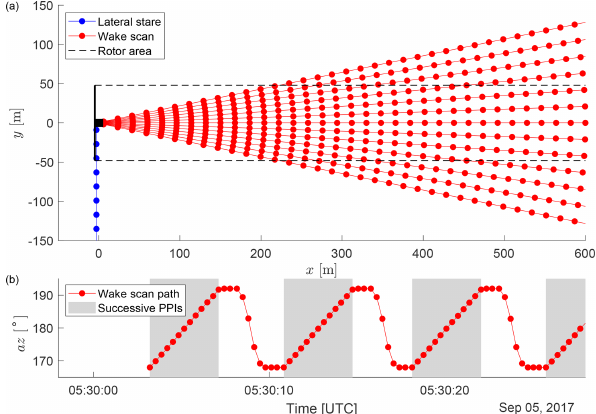
Figure 2. Scan patterns of the nacelle-mounted Doppler lidars viewed from the top (a) . Wake scans of the backward-facing Doppler lidar (red) were accompanied by measurements in a later- ally staring mode of the forward-facing Doppler lidar (blue). Lidar beams are shown as lines with range gate centres indicated as points. The wind turbine is stylized in black (not to scale), and rotor area is indicated with black dashed lines. The bottom panel shows the scanner path for a section of a wake scan (b) , where the grey area indicates the successive PPIs that together become a wake